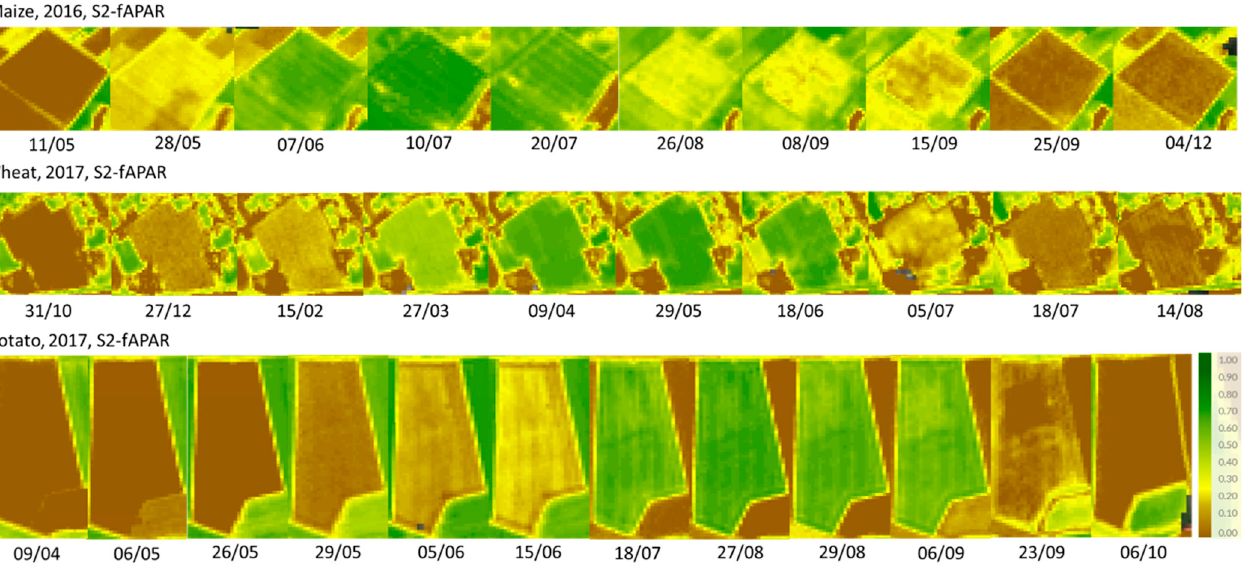
Figure 10. Sentinel-2 derived fAPAR progression for maize, winter wheat, and potato fields during 2016 and 2017, including the day/month of image acquisition.